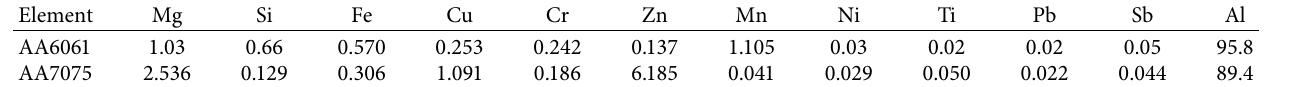
Table 1: Chemical constituents of selected base materials.